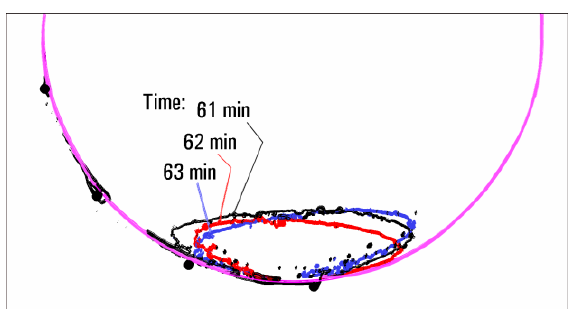
Fig. 24. Contours of photographed melted body in the last minutes of the melting process. The body obviously responds by the oscillatory motions to the unsteady convective flows present in the liquid